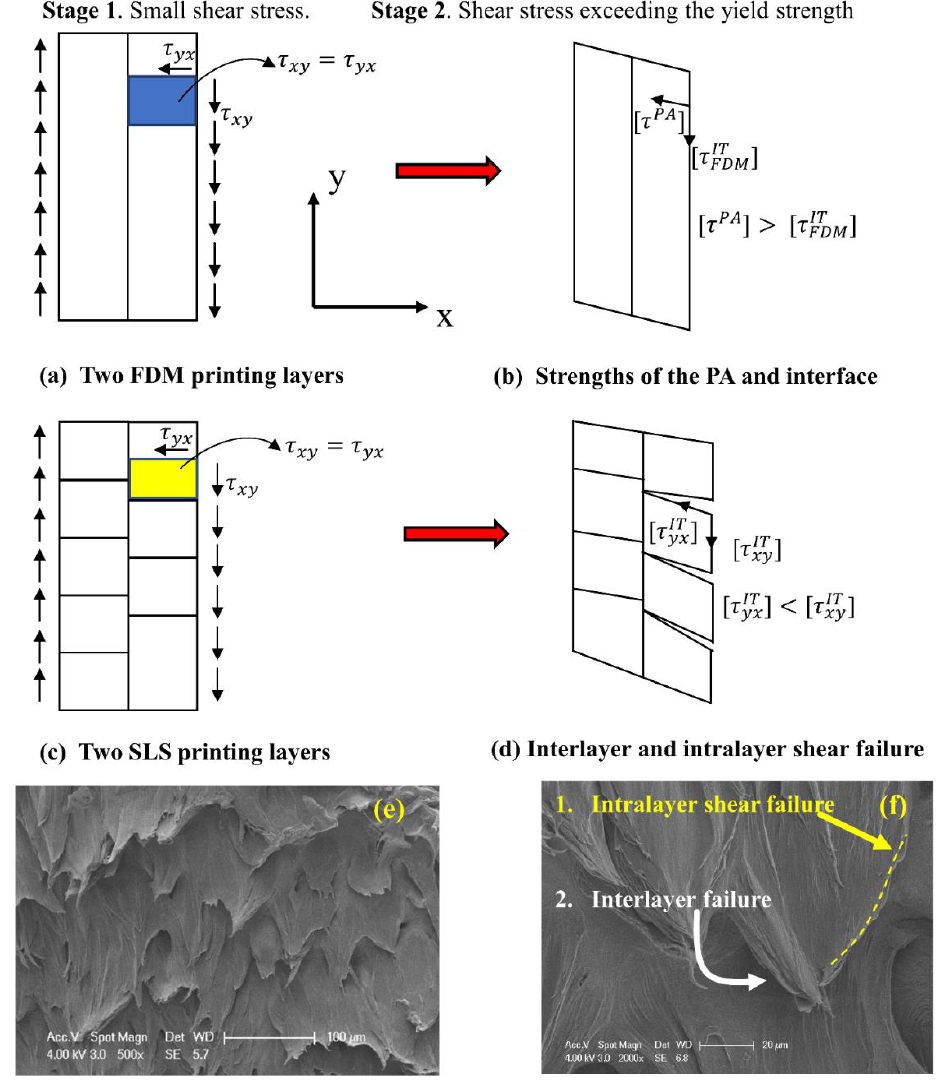
Figure 4. Assumed shear failure mechanisms from the side view of two printing layers of SLS and FDM specimens, ( a ) two FDM printing layers, ( b ) strengths of the original PA polymer and interface, ( c ) two SLS printing layers, ( d ) interlayer and intralayer shear failure, ( e ) SEM image of an SLS specimen, ( f ) two failure modes on an SEM image.